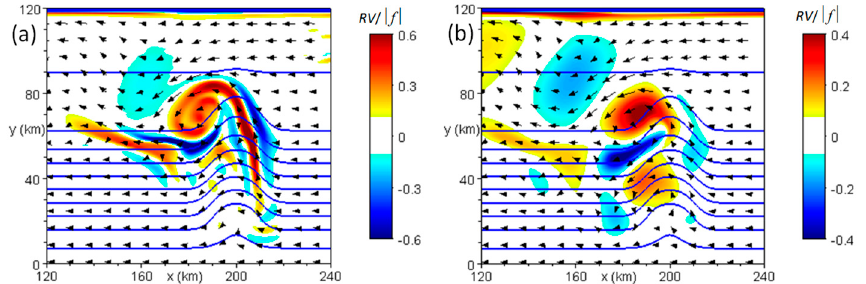
Figure 10. Same as Figure 6b, but for the canyon-upwelling scenario: ( a ) results for the full model configuration; and ( b ) results for the model run with uniform seawater density and zero friction. Note the variation of color ranges.